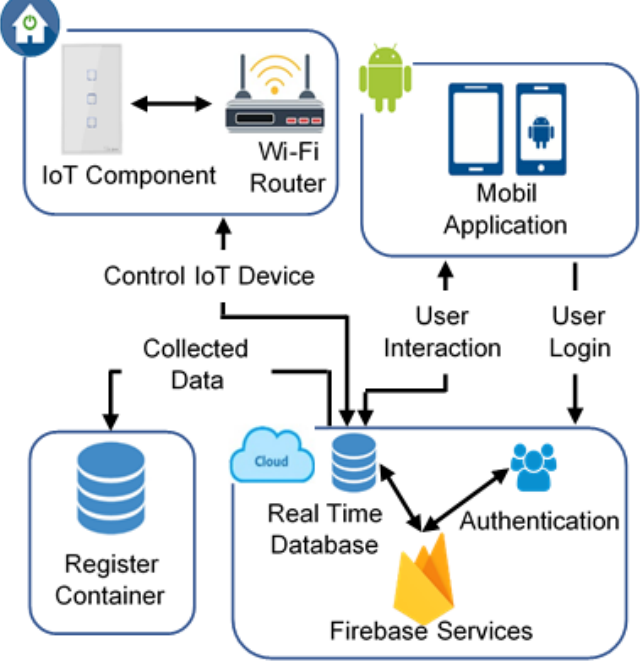
Figure 1. Platform